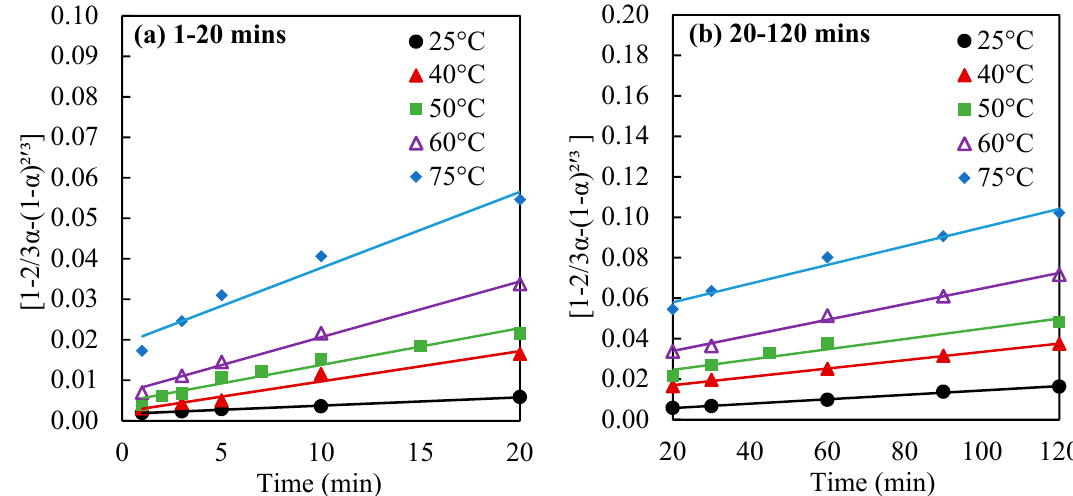
Figure 13. Kinetic modeling of total REEs recovery during the ( a ) first 20 min, and ( b ) 20–120 min of leaching at various temperatures for the Fire Clay middlings (1 M H 2 SO 4 , 530 rpm, S/L = 10 g/L, D 80 = 8.7 μ m, retention time of 120 min).